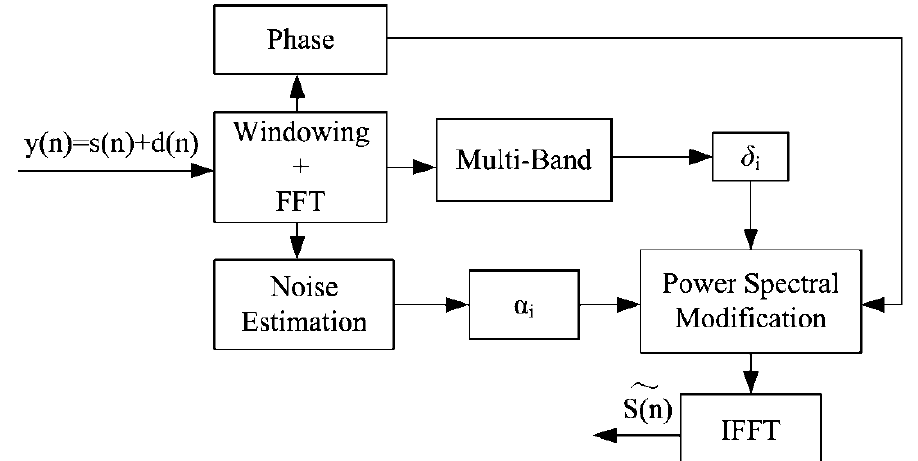
Figure 2 . The proposed speech enhancement